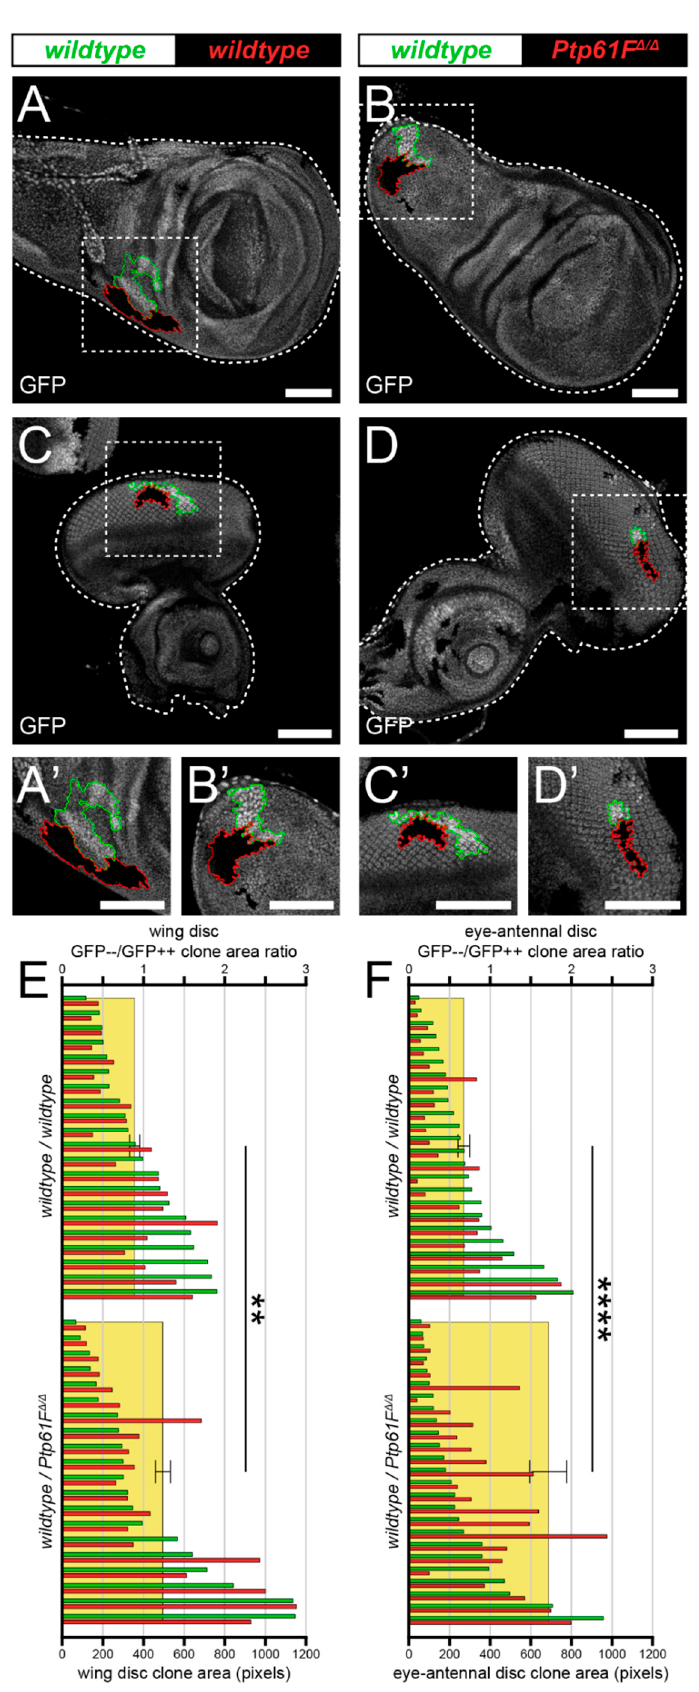
Figure 1. Ptp61F loss enhances epithelial clone relative fitness. ( A – D ) Confocal images of L3 imagi- nal tissues of the indicated genotypes (boxes at top, white indicates GFP-positive clones, black